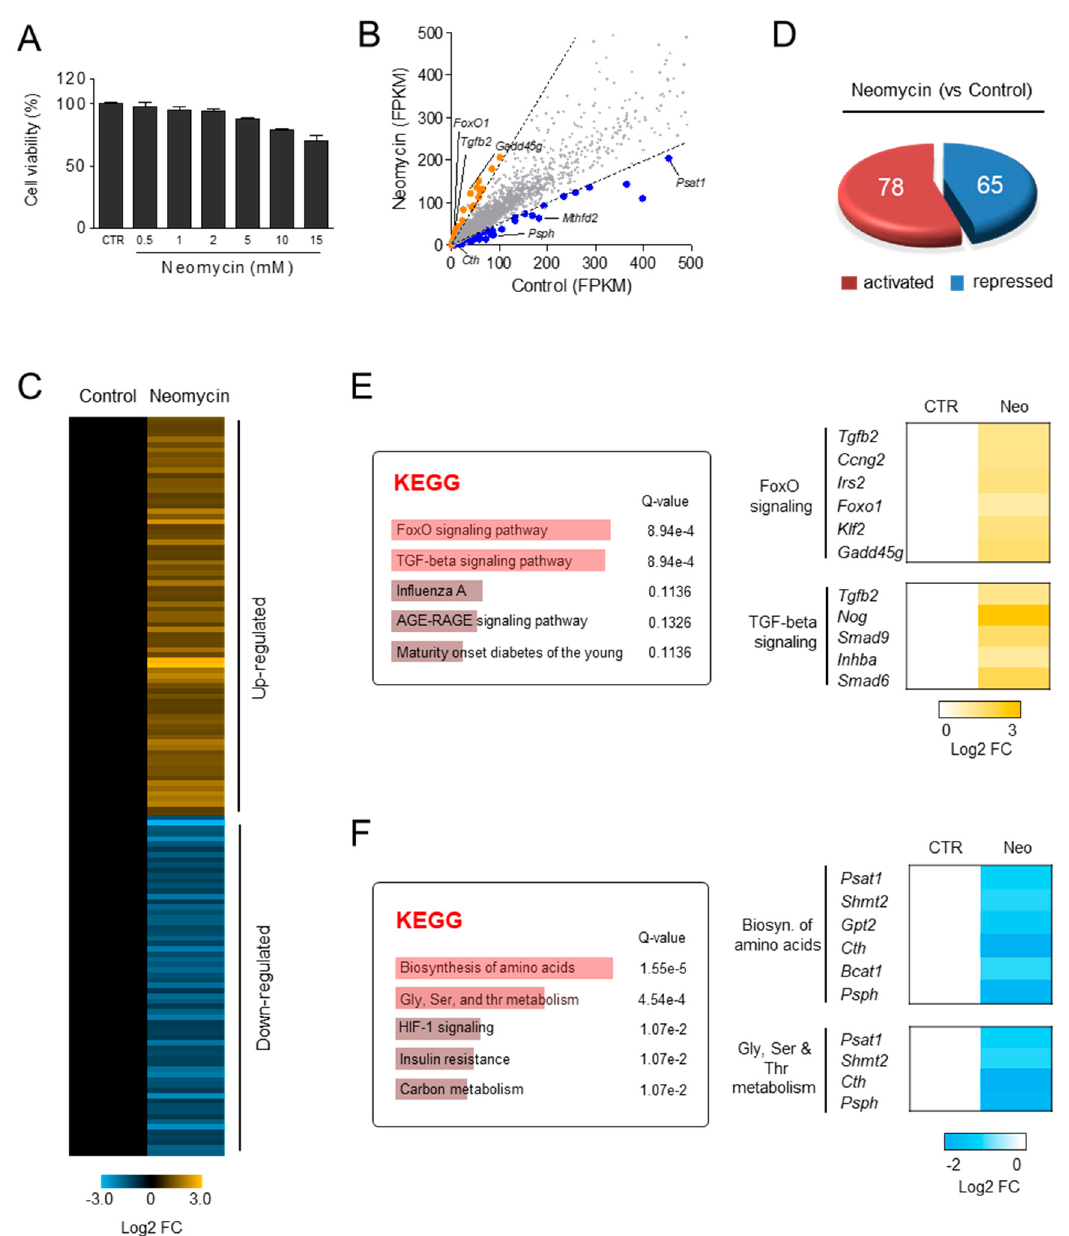
Figure 5. Differential gene expression induced by neomycin in House Ear Institute-Organ of Corti 1 (HEI-OC1) cells. ( A ) Viability of HEI-OC1 cells treated with neomycin (0.5–15 mM) for 24 h. ( B ) Scatter plot of control vs. neomycin (10 mM) group. Of the total genes, 143 were significantly altered by neomycin (FDR<0.05, |FC| > 2.0). ( C ) Heat map based on RNA-seq analysis of gene expression in HEI-OC1 cells. ( D ) Venn diagram showing the results of RNA-seq for the neomycin-regulated gene set. Genes were divided into neomycin-induced and neomycin-repressed gene groups. ( E ) Genes up-regulated by neomycin were categorized according to gene function by Kyoto Encyclopedia of Genes and Genomes (KEGG) analysis (Q < 0.05, left panel). Heat map generated using RNA-seq of gene sets in FoxO and TGF- β signaling (right panel). ( F ) Genes down-regulated by neomycin were analyzed by KEGG (Q < 0.05, left panel). Heat map of genes in amino acid biosynthesis and glycine, serine, and threonine metabolism (right panel).